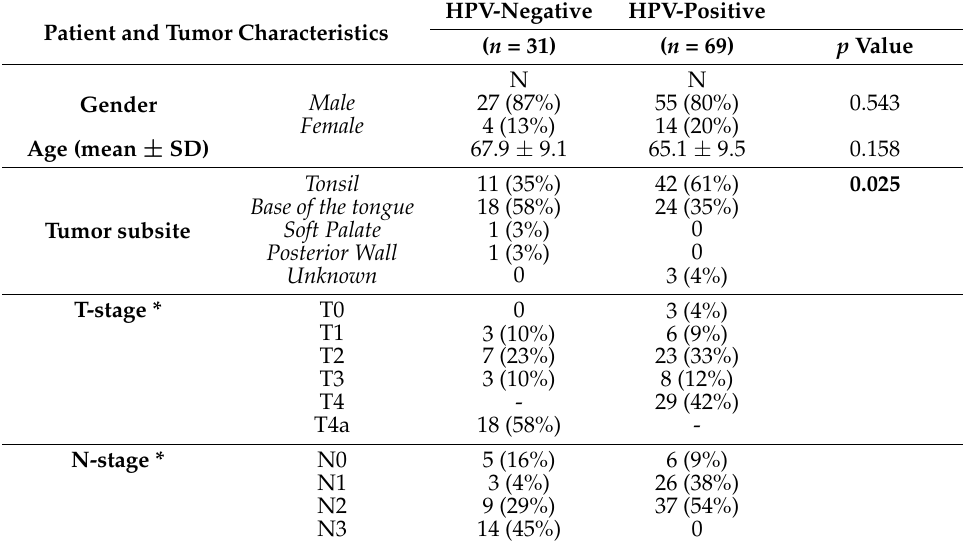
Table 1. Characteristics of patients and